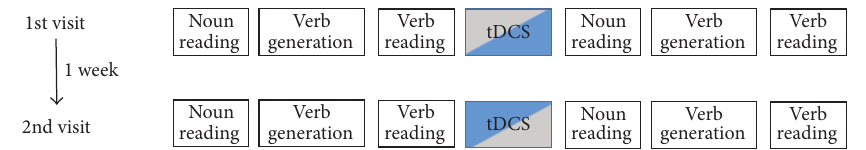
Figure 1: Study design: participants complete 2 visits with a one-week interval, receiving cathodal (blue) or sham c-tDCS (grey) in a counterbalanced